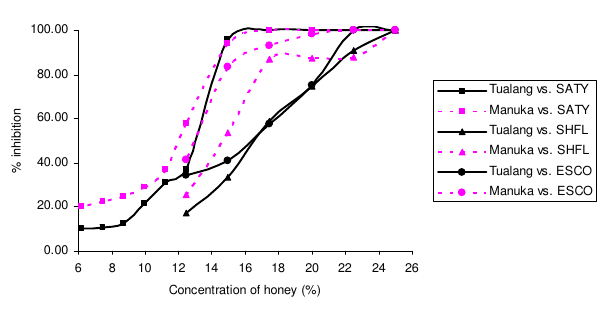
Tualang vs. SATY Manuka vs. SATY Tualang vs. SHFL Manuka vs. SHFL Tualang vs. ESCO Manuka vs. ESCO